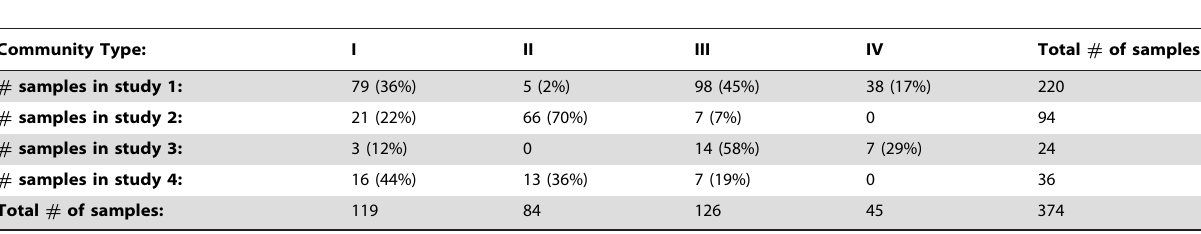
Table 1. Distribution of community types observed in each